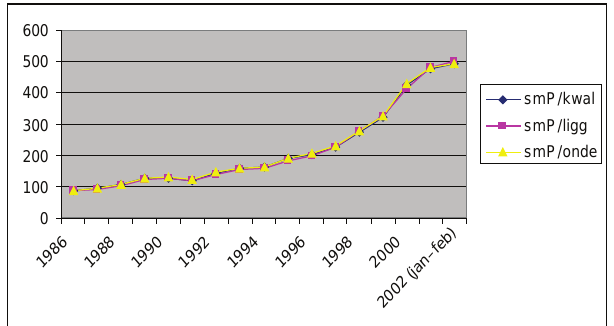
Figure 1. time-series of the square meter price related to three different quality measures aggregated for